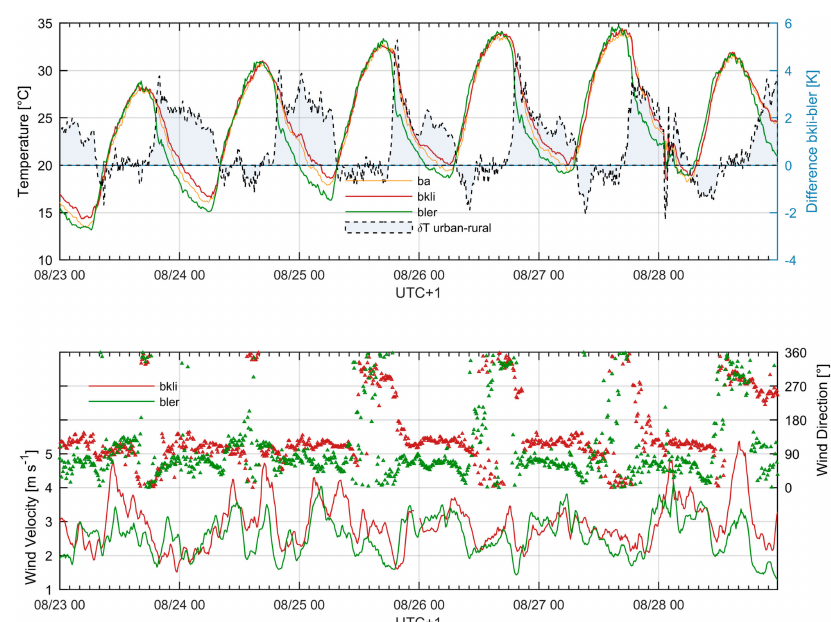
Figure 7. Time series of air temperature (upper plot) and wind (lower plot) measurements at urban (red and orange) and rural (green) reference stations for the entire investigation period. The light blue area in the upper plot represents the difference between the rural and the urban reference station. The x -axis label indicates the time in the following format: mm/dd/hh